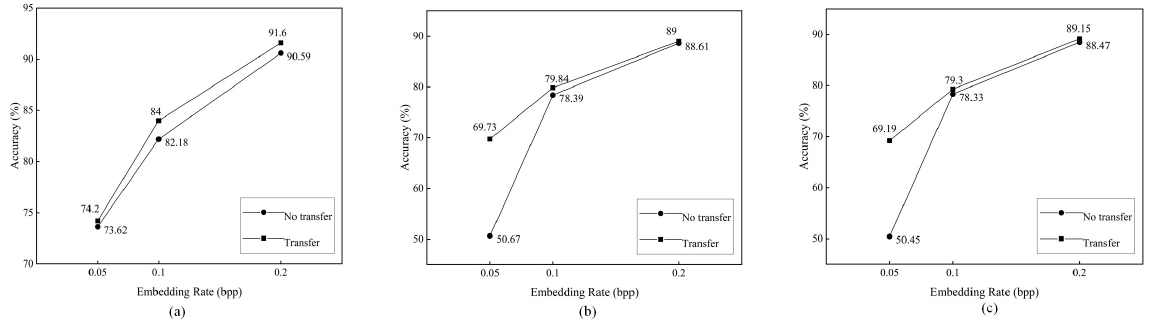
Figure 5. The accuracy is obtained using each of the three steganographic algorithms. ( a ) Detection accuracy using the S-UNIWARD algorithm. ( b ) Detection accuracy using the WOW algorithm. ( c ) Detection accuracy using the HUGO algorithm.